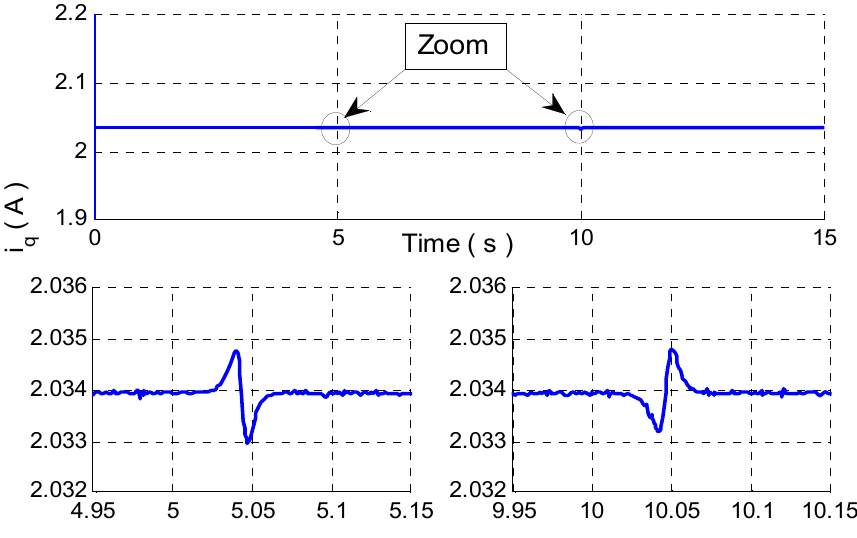
Figure 8. Current i q , with zoom.